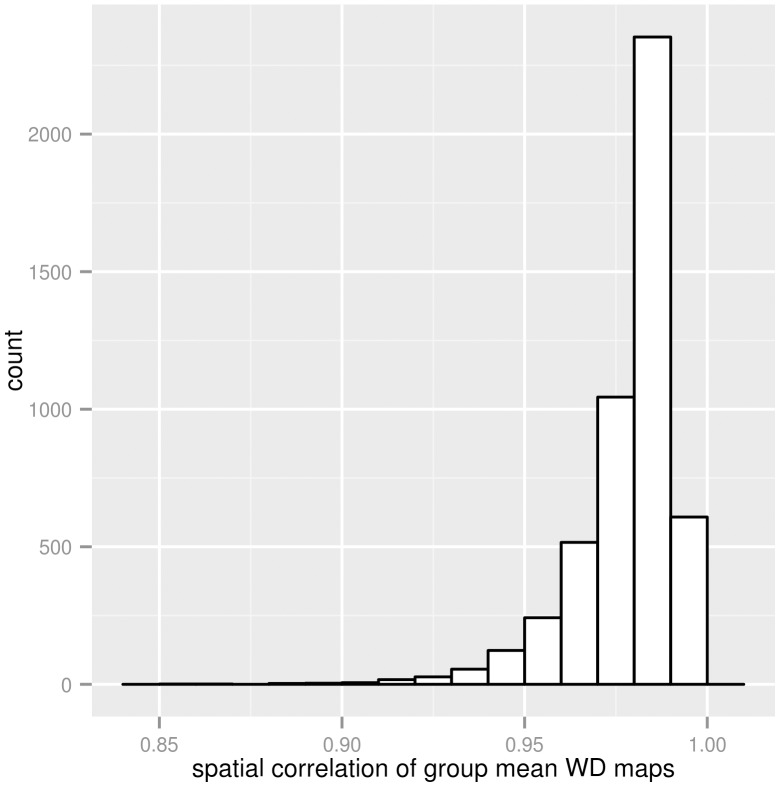
Histogram of group averaged voxel-wise displacement correlations based on 5000 random permutations.Temporally averaged standard-space voxel-wise displacement maps were averaged across the subjects of two randomly assigned groups. Spatial Pearson correlation was calculated between these group-mean voxel-wise displacement maps ). The histogram of this inter-group voxel-wise displacement correlation was computed based on 5000 random group formulation. Group-pairs with extrem inter-group differences in voxel-wise displacement were chosen for further analysis.